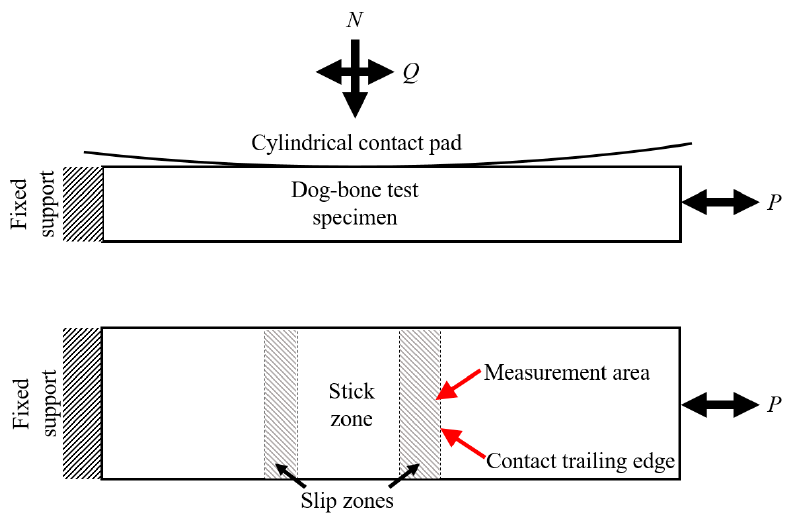
Figure 16. Scheme of zone where relaxed residual stress was measured.